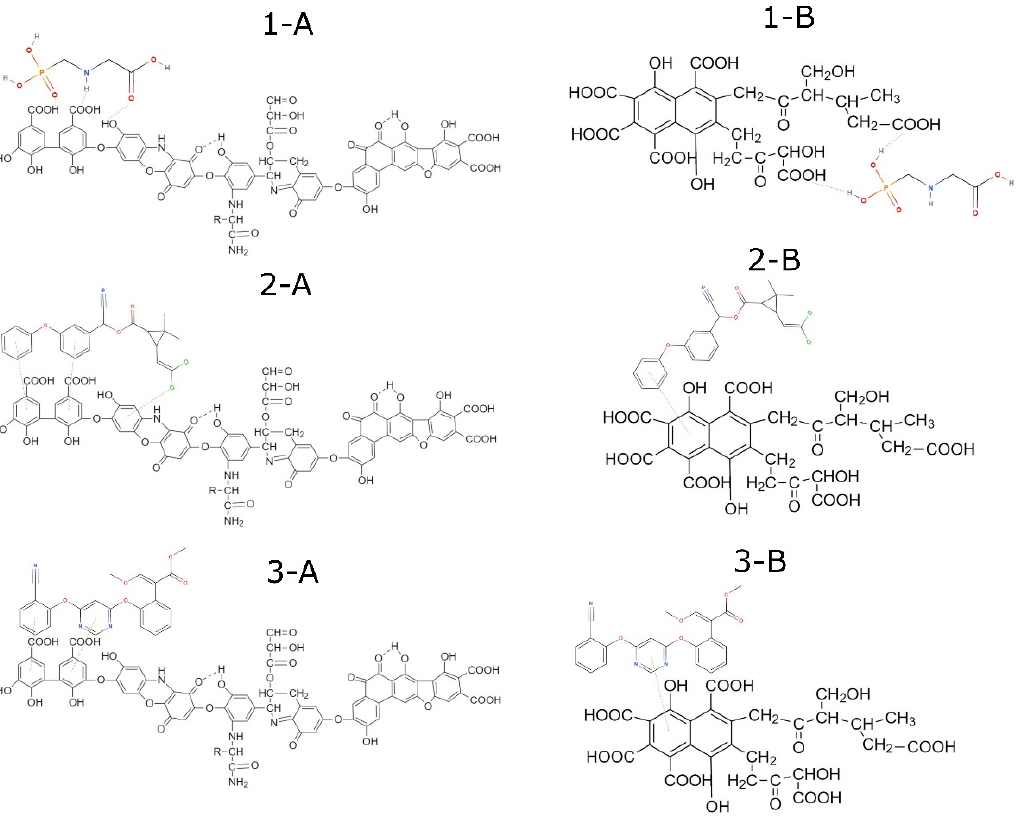
Figure 8. Tentative sorption mechanism of glyphosate (1), cypermethrin (2), and azoxystrobin (3) using HA (A) and FA (B).